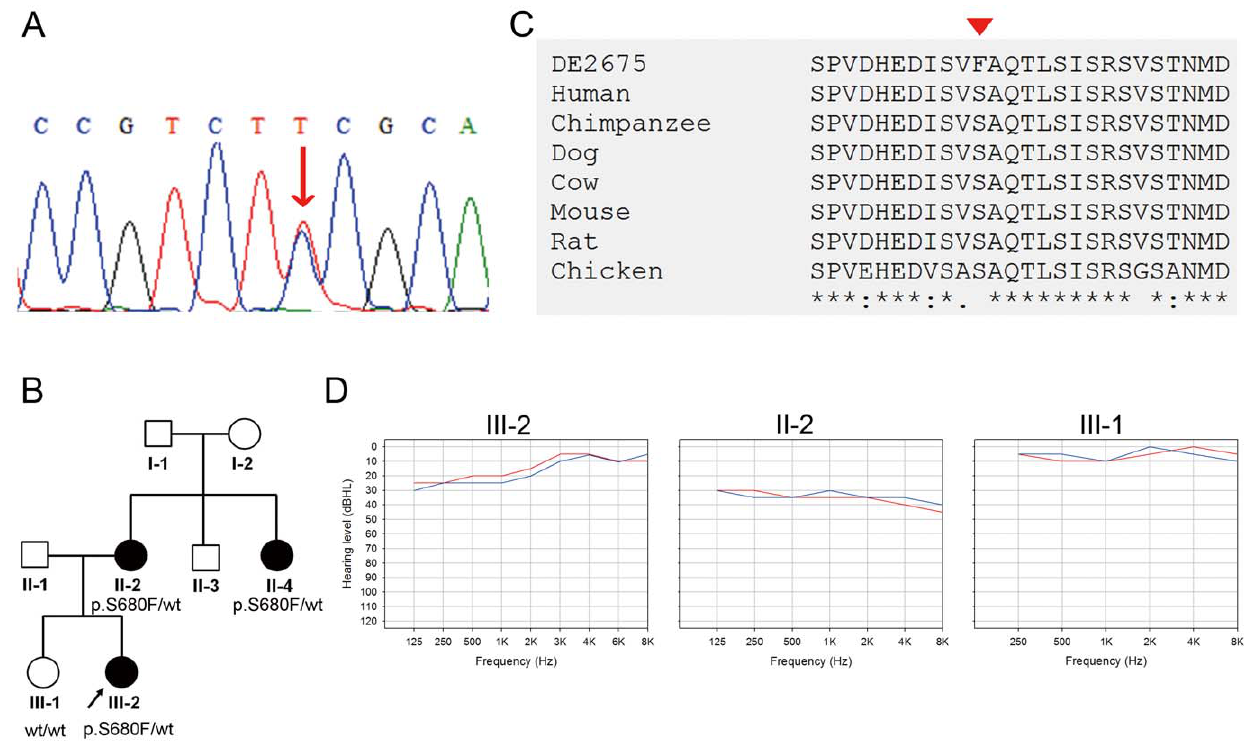
Figure 3. The KCNQ4 p.S680F variant identified in Family DE2675. (A) Sanger sequence of the KCNQ4 p.S680F variant. Arrow: nucleotide change c.1877C . T (p.S680F) variant. (B) Pedigree and segregation pattern in Family DE2675. (C) Evolutionary conservation of the p.S680 residue. Arrowhead: variant site. (D) Audiograms of the affected family members (II-2 & III-2) and an unaffected member (III-1) of Family DE2675. Hearing levels of the right ear and left ear are marked with red and blue lines,